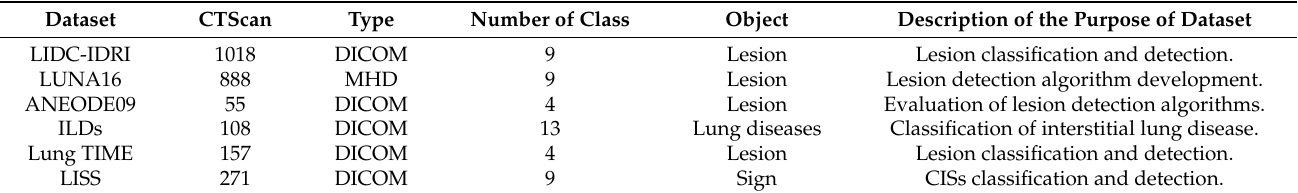
Table 1. Dataset description